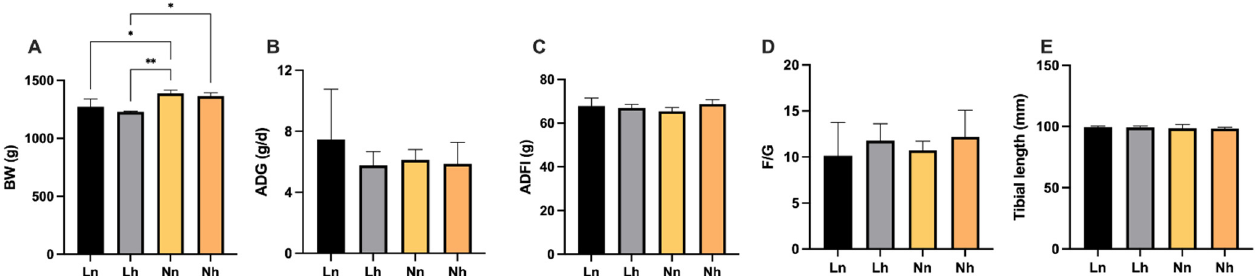
Figure 3. Effects of phosphorus restriction in brooding stage and subsequent recovery on growth performance of layers at 20 weeks of age. (A) BW ( B ) ADG ( C ) ADFI ( D ) F/G ( E ) Tibial length. BW = body weight, ADG = average daily gain; ADFI = average daily feed intake; F/G = the ratio of feed to gain. Data are shown as mean ± SEM. * p < 0.05, ** p < 0.01. Ln = group fed 0.13% nPP at 1–8 weeks and fed 0.39% nPP at 9–20 weeks; Lh = group fed 0.13% nPP at 1–8 weeks and fed 0.45% nPP at 9–20 weeks; Nn = group fed 0.45% nPP at 1–8 weeks and fed 0.39% nPP at 9–20 weeks; Nh = group fed 0.45% nPP at 1– 8 weeks and fed 0.45% nPP at 9–20 weeks. n = 6 per group.